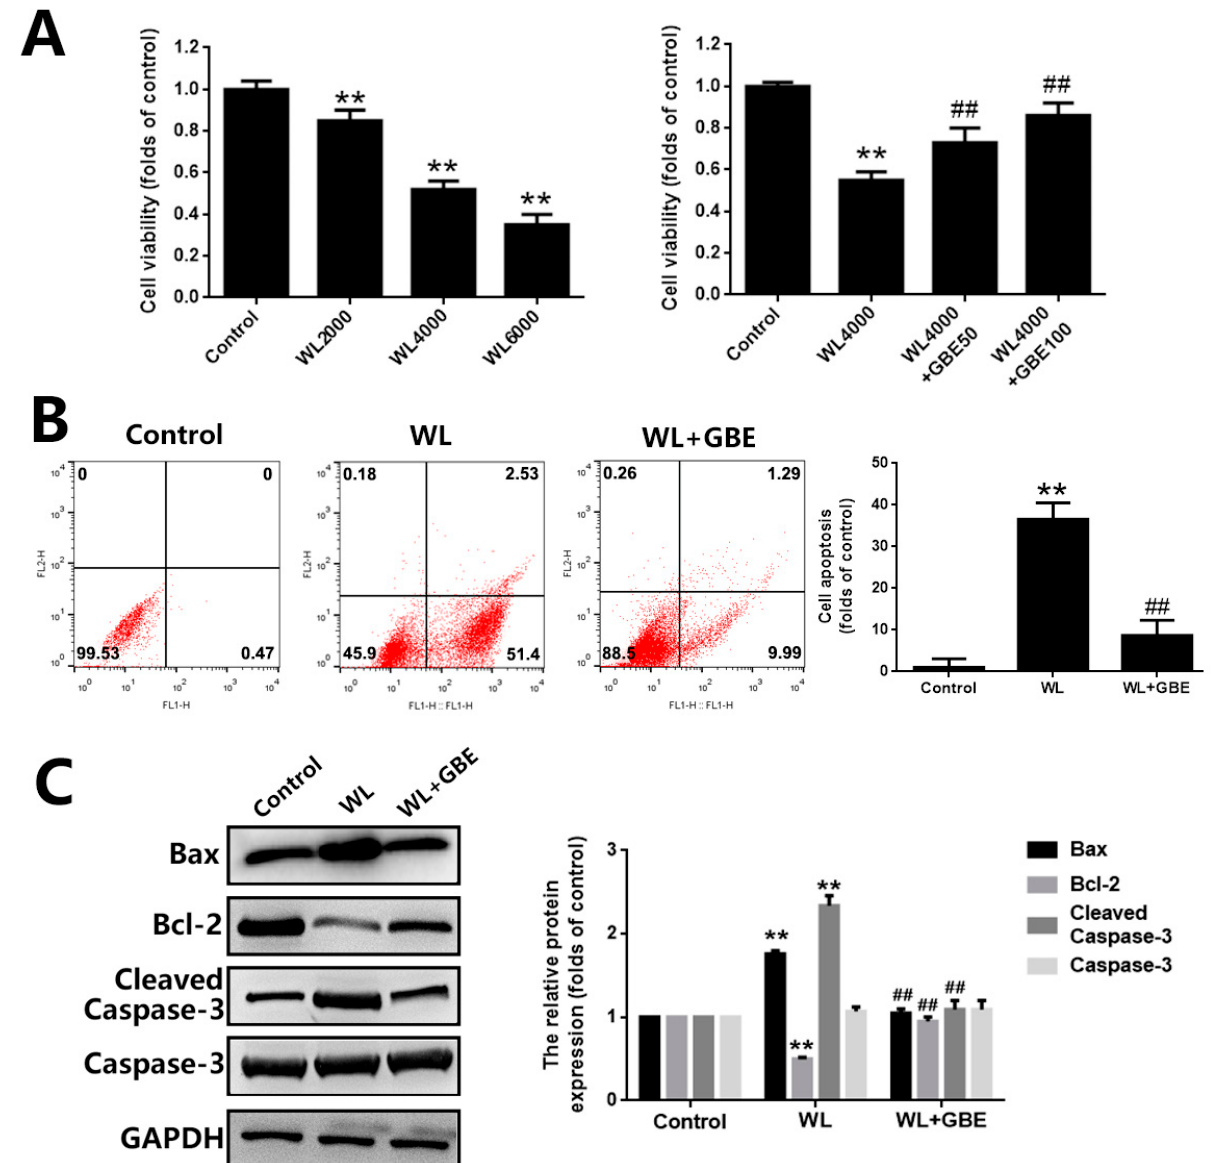
Figure 1. The effect of GBE on photoreceptor degeneration in 661W cells exposed to WL illumination. Cells from the 661W cell line pre-treated with GBE (50 or 100 mg/L, 24 h) were exposed to WL (4000 lux) for 2 h. ( A ) Cell viability upon WL treatment (2000, 4000 or 6000 lux) alone (left panel) and with GBE pre-treatment (right panel) was assessed by MTT assay. ( B ) Cell apoptosis was analyzed by Annexin V-FITC and PI double-staining assay. Representative images of cell apoptotic profiles are shown in the left panel and the percentages of apoptotic cells in each group are summarized in the right panel. ( C ) The expressions of apoptosis-related proteins (Bax, Bcl-2 and Caspase-3) were evaluated by Western blotting (left panel). The densitometry analysis of protein expression is shown in the right panel. ** p < 0.01 vs. Control, ## p < 0.01 vs. WL. WL: white light.